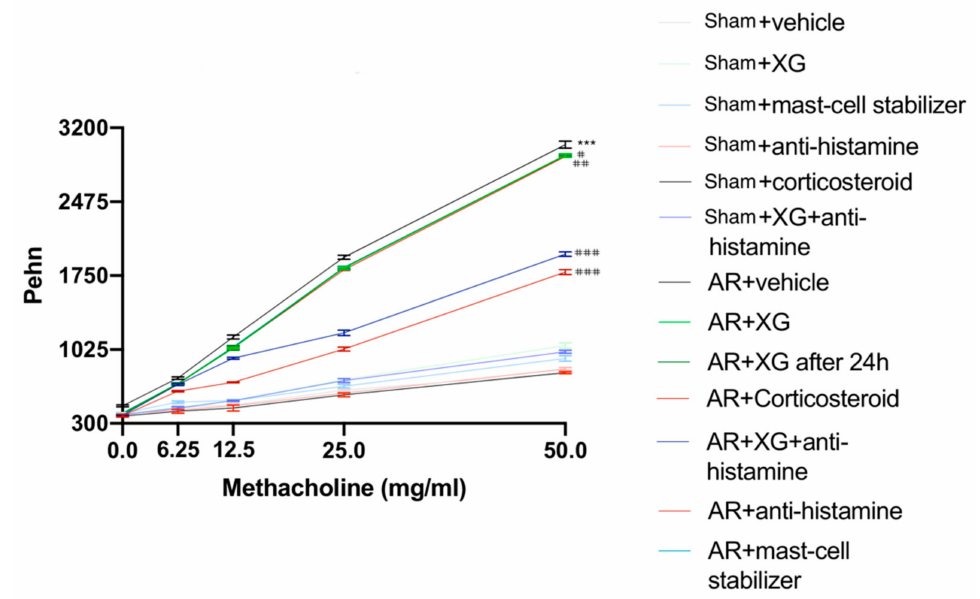
Figure 2. Effect of xyloglucan on assessment of airway reactivity. No considerable variations in Penh were detected in all sham groups following nebulization of saline solution. Contrarily, in AR-mice, the exposure to increasing concentrations of MCh increased Penh levels. On the other hand, such levels were considerably reduced following single treatments with XG, the corticosteroid, antihistamine and the mast cell stabilizer. Additionally, XG and antihistamine co-administration showed an efficacious result comparable to corticosteroid standard care. Data are representative of at least three independent experiments. Values are means ± SEM. Two-Way ANOVA test. *** p < 0.001; # p < 0.05 vs. AR + vehicle; ## p < 0.01 vs. AR + vehicle; ### p < 0.001 vs. AR +